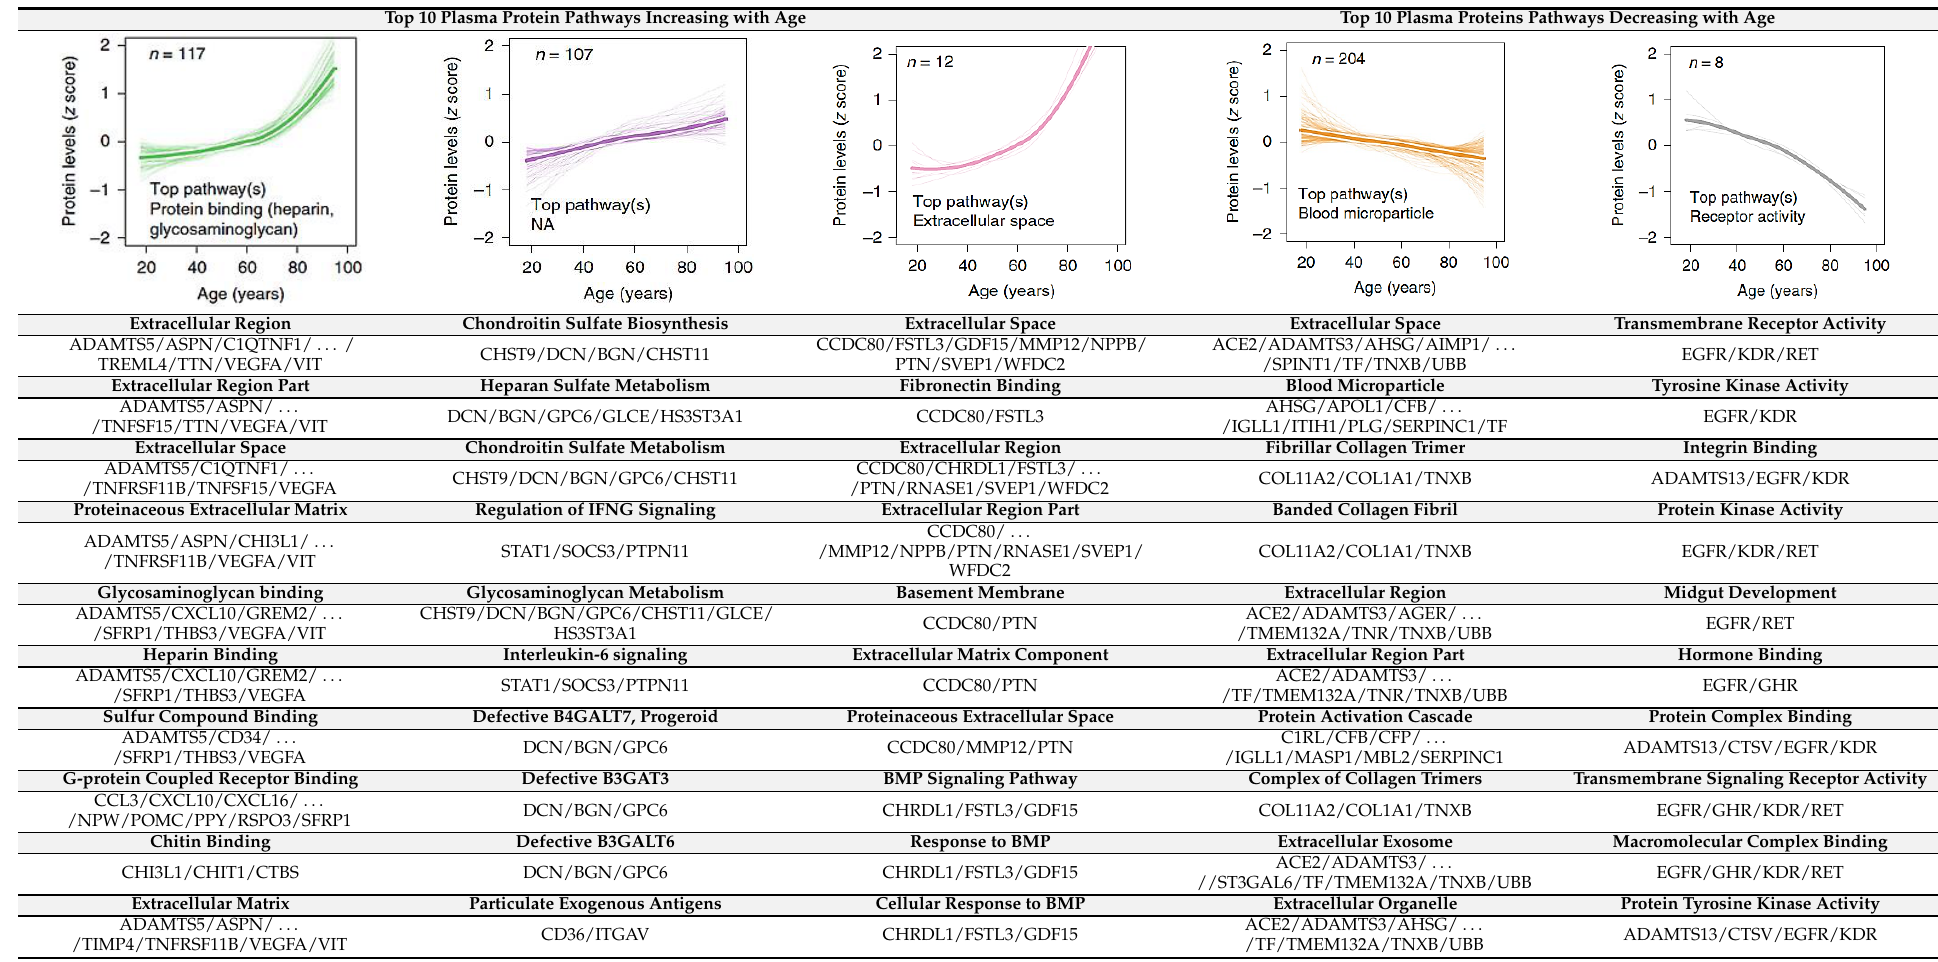
Table 1. Clusters of protein trajectories that reflect changes with age coinciding with the onset of aging, and the top 10 plasma proteins involved in them [72]. Top 10 Plasma Protein Pathways Increasing With Age Top 10 Plasma Proteins Pathways Decreasing with Age